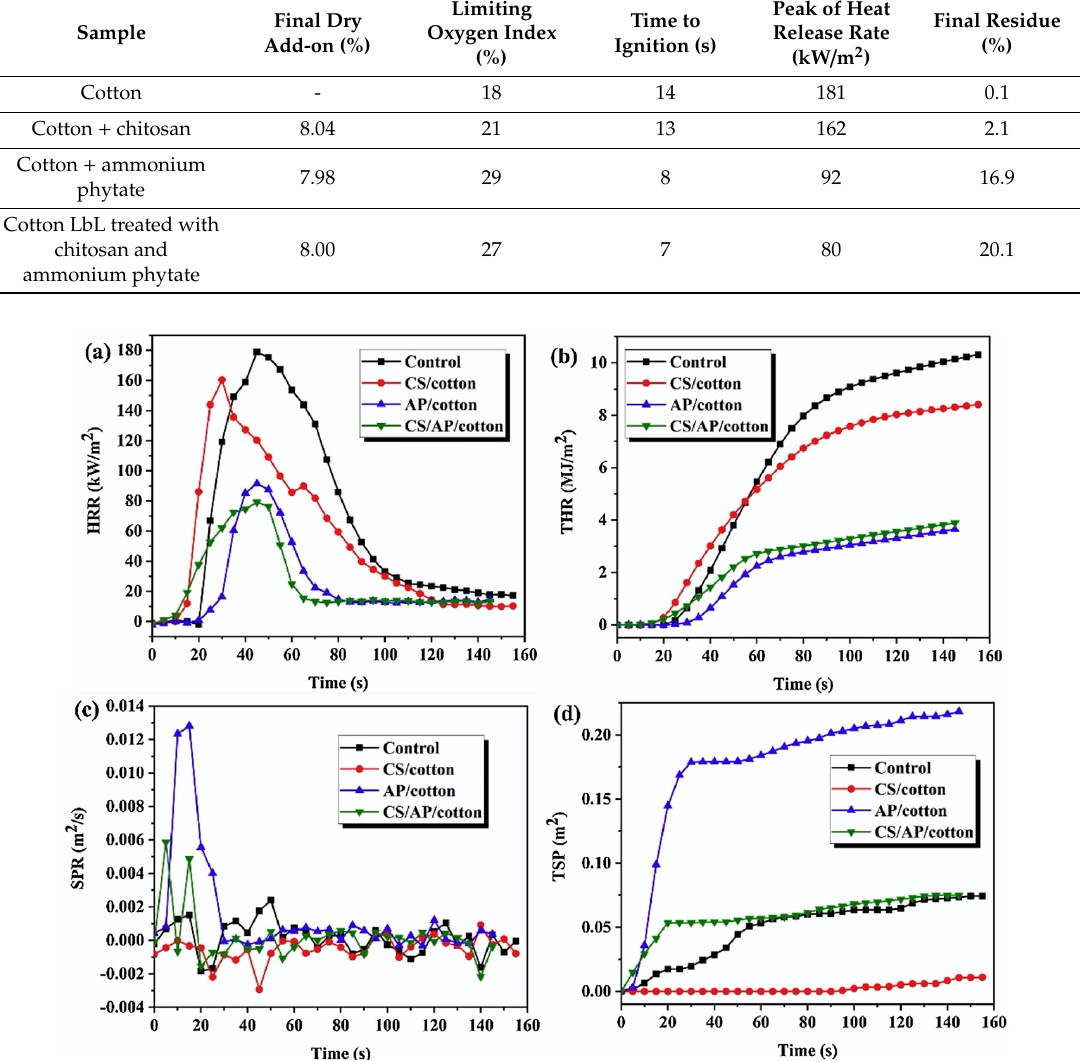
Figure 19. Results from cone calorimetry tests for untreated and treated cotton fabrics. Heat Release